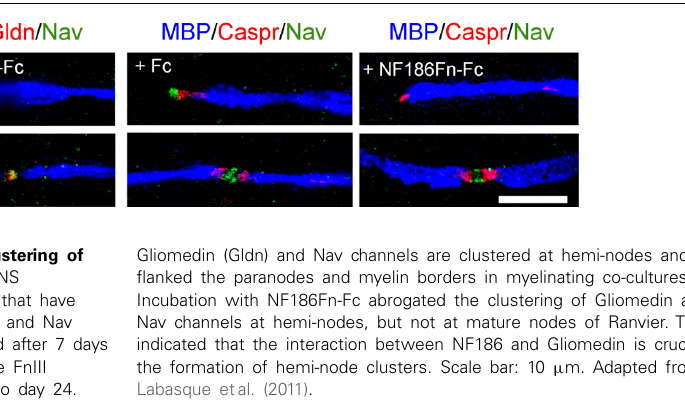
FIGURE 2 | Soluble FnIII domains of NF186 inhibit the clustering of Gliomedin and Nav channels at hemi-nodes. These are PNS myelinating co-cultures of DRG neurons with Schwann cells that have been triple-stained for MBP (blue), Caspr or Gliomedin (red), and Nav channels (green). Myelination was induced with ascorbic acid after 7 days in vitro . Co-cultures were treated with control Fc or with the FnIII domains of NF186 fused with Fc (NF186Fn-Fc) from day 7 to day 24.